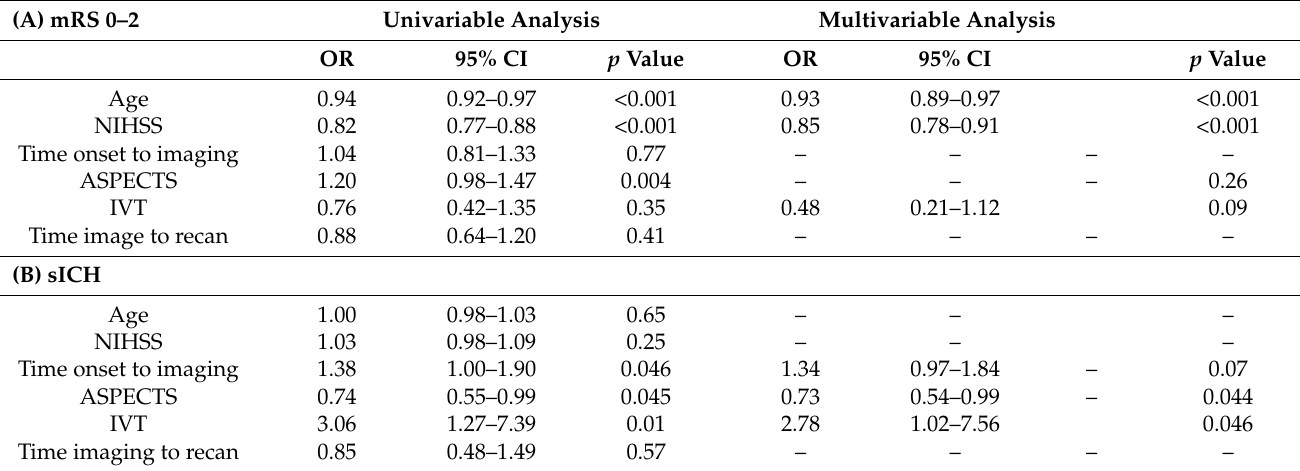
Table 2. Binary logistic regression analysis for good clinical outcome (A; mRS 0–2) and for symp- tomatic intracranial hemorrhage (B; sICH).